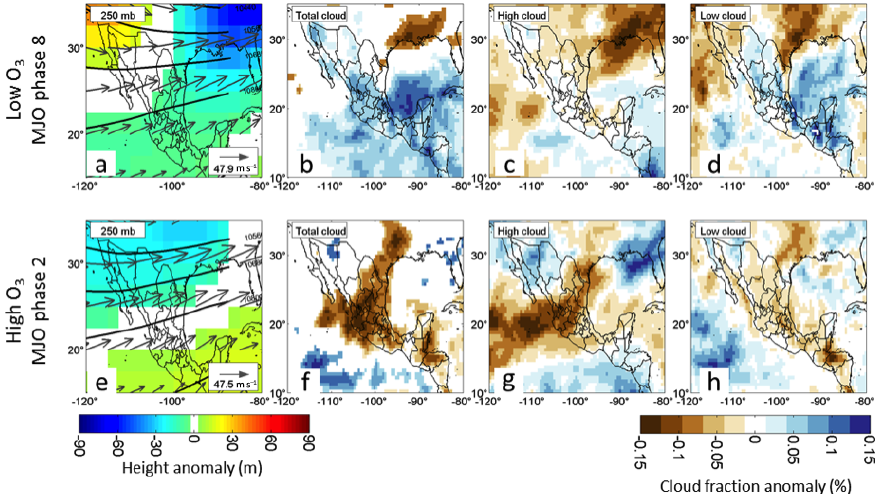
Figure 8. Composites of 250hPa height (in m), height anomaly (in m), and mean wind (a) , and total cloud fraction (in %; b ), high cloud fraction (in %; c ), and low cloud fraction (in %; d ) for winter days in active MJO phase 8. (e–h) Same as panels (a–d) but for winter days in active MJO phase 2. Phases 8 and 2 were the phases with lowest and highest respective winter ozone concentrations in Mexico City.